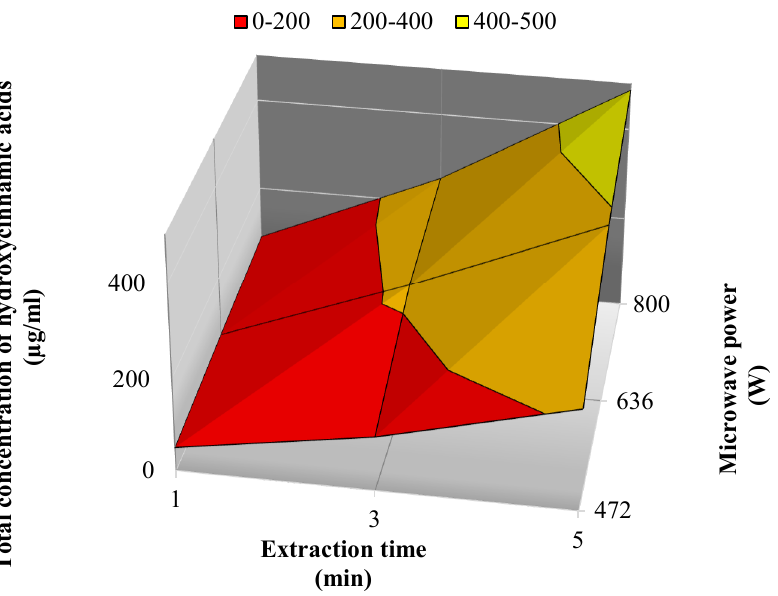
Figure 1. The effect of microwave power and extraction duration on total concentration of hydroxycinnamic acids.